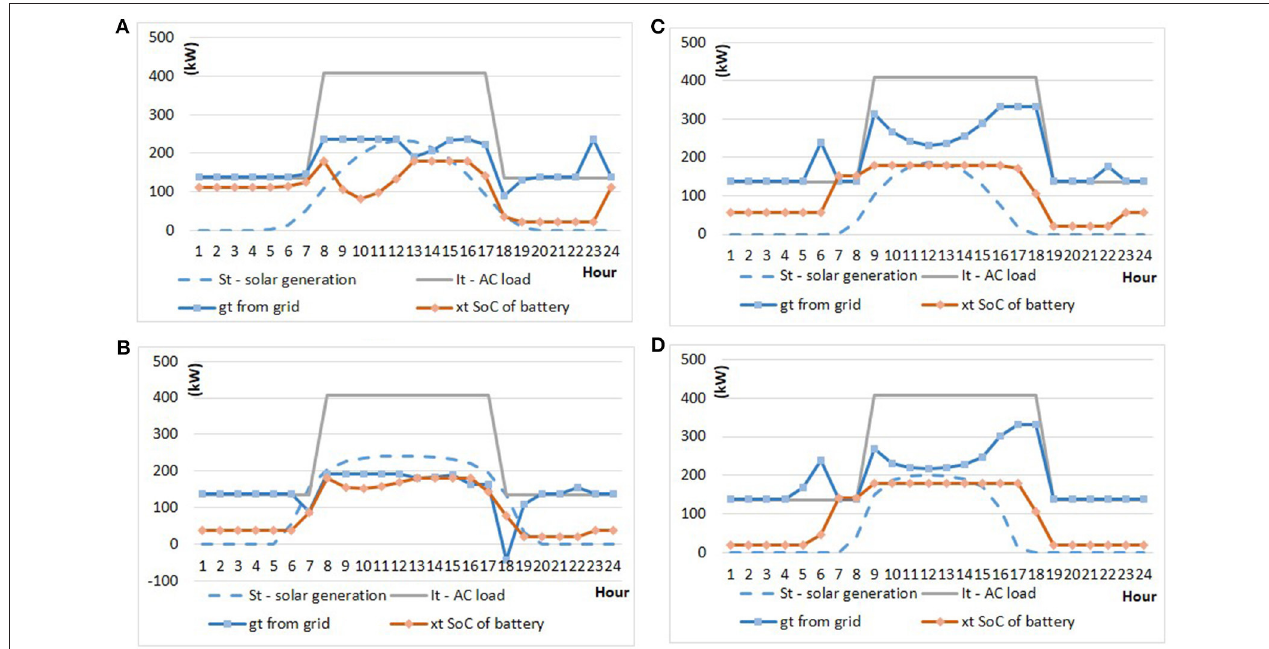
FIGURE 5 | Example optimum battery schedules (kWh) over a 24h workday for Lancaster, CA, with an 8a.m. (A) PV and (B) CPV during June and (C) PV and (D) CPV during December.